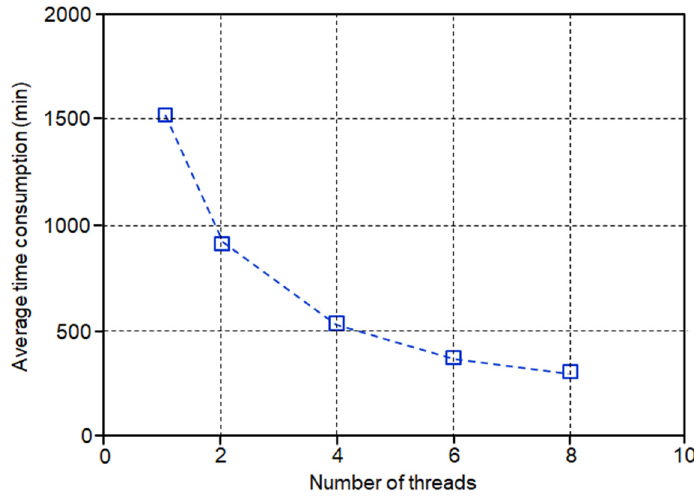
Figure 12. Relationship between average computing time and thread number in 3D SPH model- ing.